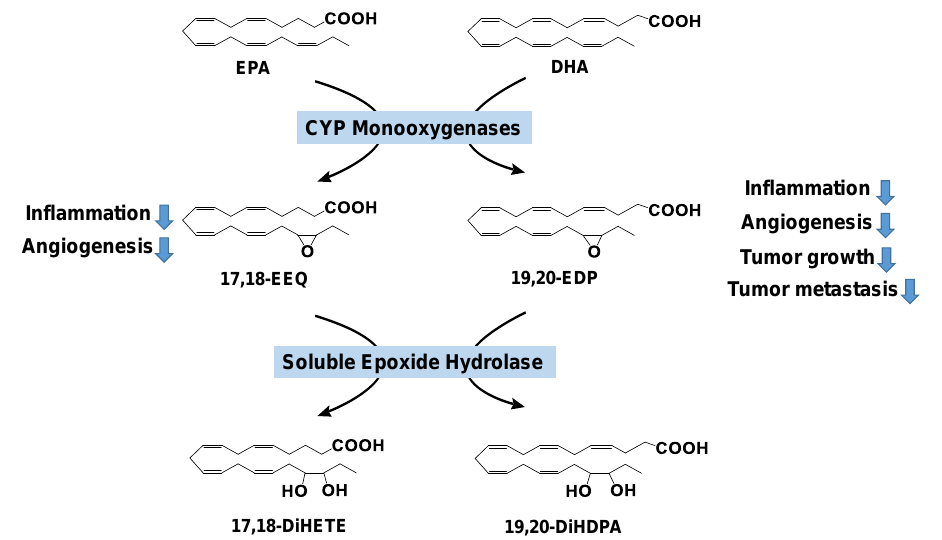
Figure 1. Cytochrome P450 (CYP) pathway-mediated metabolism of ω -3 PUFAs. EPA, eicosapentaenoic acid; DHA, docosahexaenoic acid; EEQ, epoxyeicosatetraenoic acid; EDP, epoxydocosapentaenoic acid; DiHETE, dihydroxy-eicoxatetraeonic acid; DiHDPA, dihydroxy-docosapentaenoic acid.